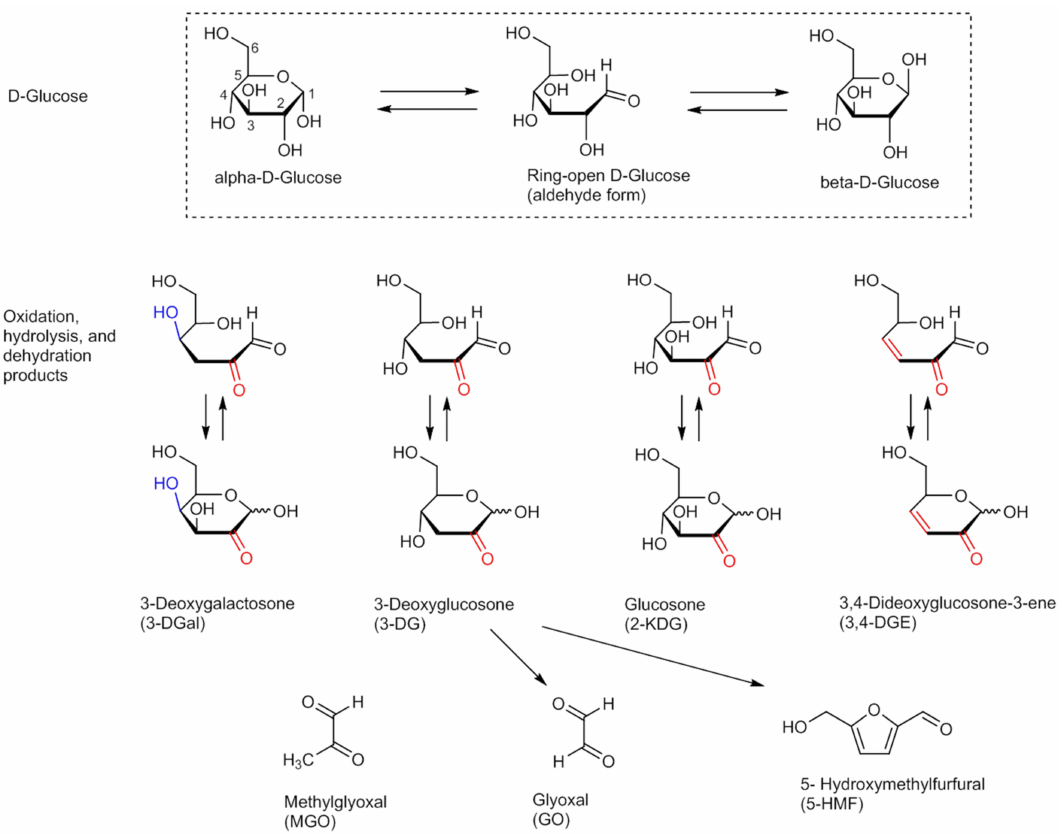
Figure 1. Reaction products of D -glucose due to oxidation, hydrolysis, and dehydration reactions observed during autoclaving of aqueous glucose